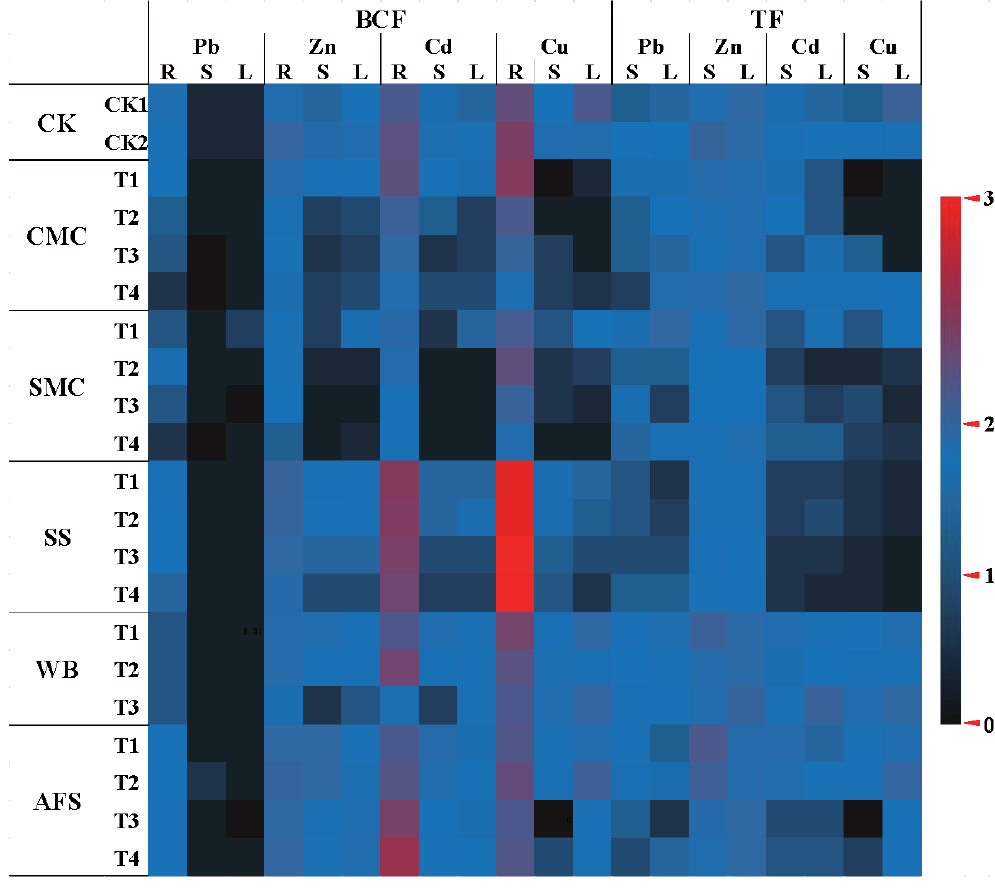
Figure 3. Bioconcentration factors and translocation factors of Pb, Zn, Cd and Cu in A. fruticosa tissues grown in treated and untreated tailings. CK1 = Only tailings and CK2 = Tailings plus TSP. The amendment treatments are denoted as T1, T2, T3 and T4. CK1: Control 1; CK2: Control 2; CMC: